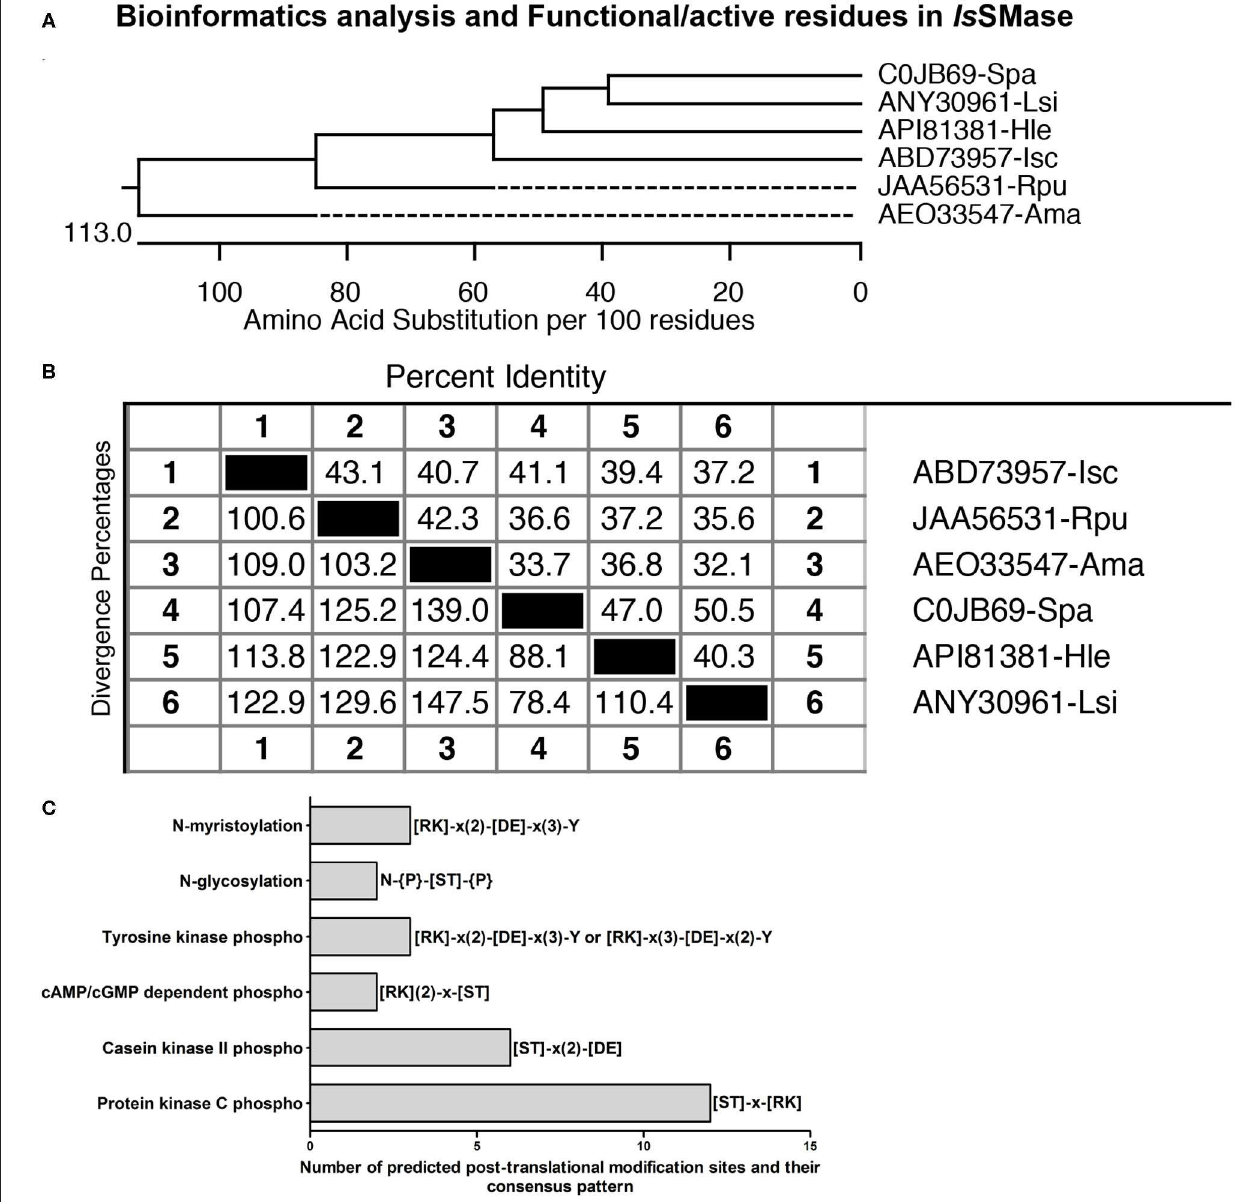
FIGURE 2 | Comparative bioinformatics analysis of Is SMase with other orthologs. (A) Phylogenetic analysis comparing Is SMase and other orthologs was performed in DNASTAR by ClustalW slow/accurate alignment method using Gonnet as default value for protein weight matrix. Scale at the bottom denotes amino acid substitutions per 100 amino acid residues. (B) Percent identity (horizontally above black boxed diagonal) and divergence (vertically below black boxed diagonal) of Is SMase nucleotide sequence in comparison to R. pulchellus ( Rpu ) sphingomyelin phosphodiesterase, A. maculatum ( Ama ) hypothetical protein, S. patagonicus ( Spa ) sphingomyelinase D, H. lepturus ( Hle ) venom toxin, and L. similis ( Lsi ) loxtox protein sequence is shown. (C) Protein feature prediction analysis showing Is SMase protein modification sites and relevant amino acids as functionally active residues in those modifications. Is SMase contains 12 protein kinase C (PKC) phospho-sites, 6 casein kinase II phospho-sites, 2 cAMP/cGMP-dependent phospho-sites, 3 tyrosine kinase phospho-sites, 2 N-glycosylation sites, and 3 N-myristoylation